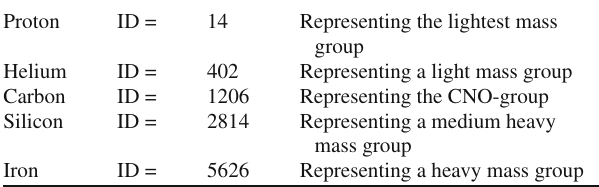
CORSIKA simulation package. CORSIKA has been written especially for KASCADE and extended since then to